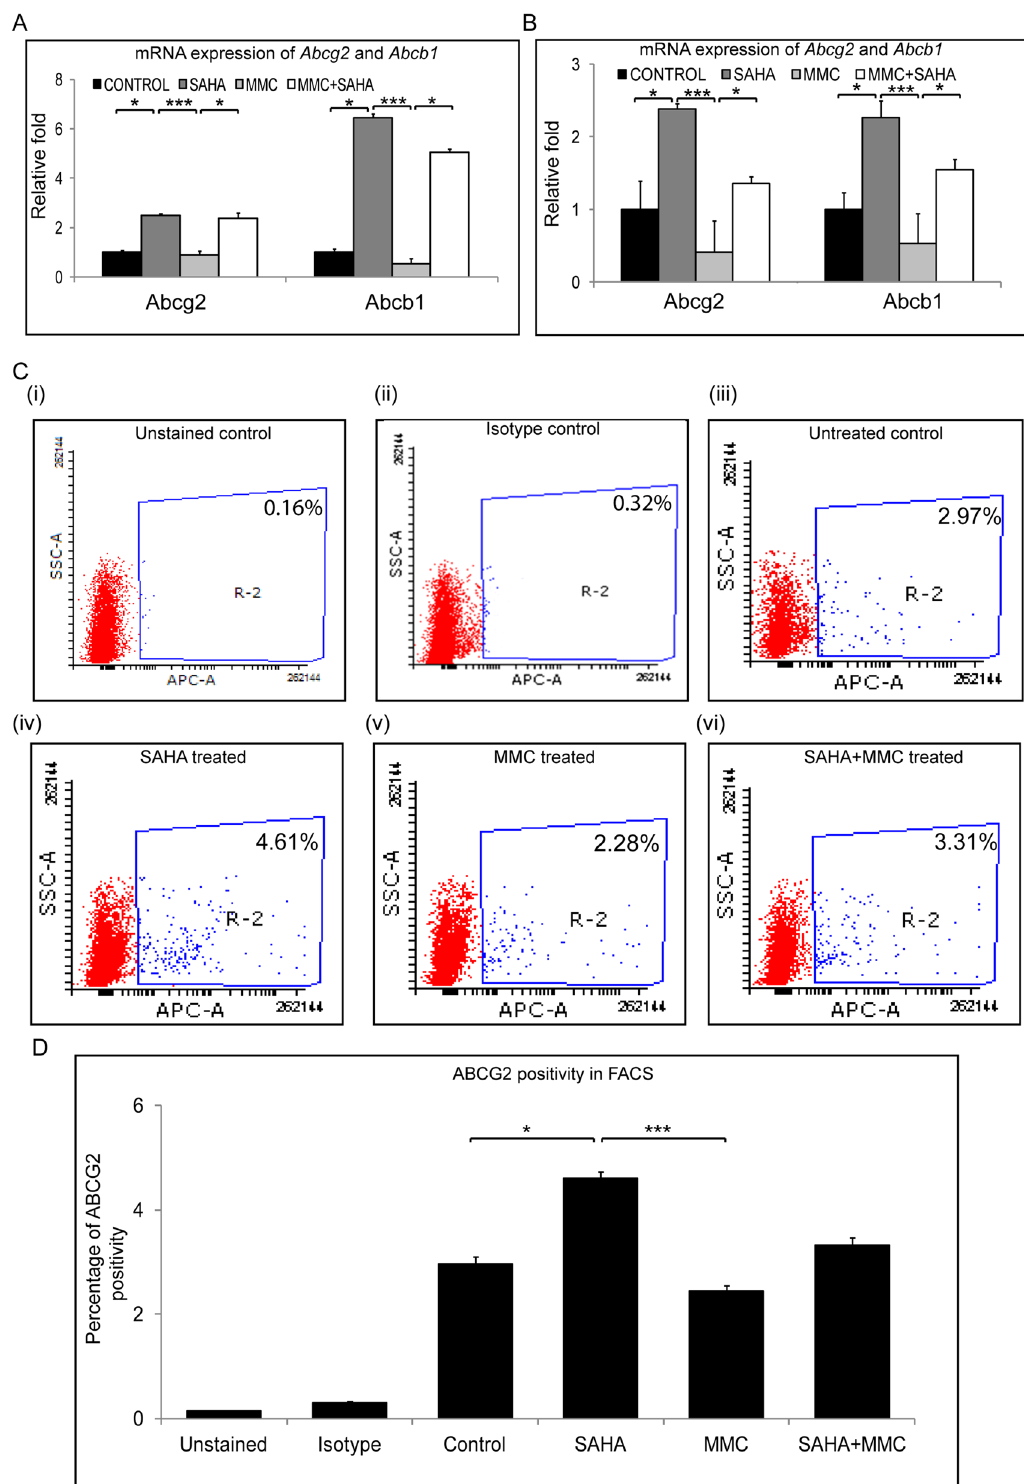
Figure 6. Effect of MMC and SAHA on MDR proteins. Relative mRNA expression levels of Abcg2 and Abcb1 in cells of study group 1 ( A ) and study group 2 ( B ) (n = 5). Representative FACS plots showing the effect of treatment on cells of study group 1 on ABCG2 levels ( C (i-vi)) (n = 4). Graphical representation of percentage of ABCG2 positivity ( D ) Statistical significance based on one way ANOVA test denoted by *p ≤ 0.05, ***p ≤ 0.001 was calculated using statistical software GraphPad PRISM Ver